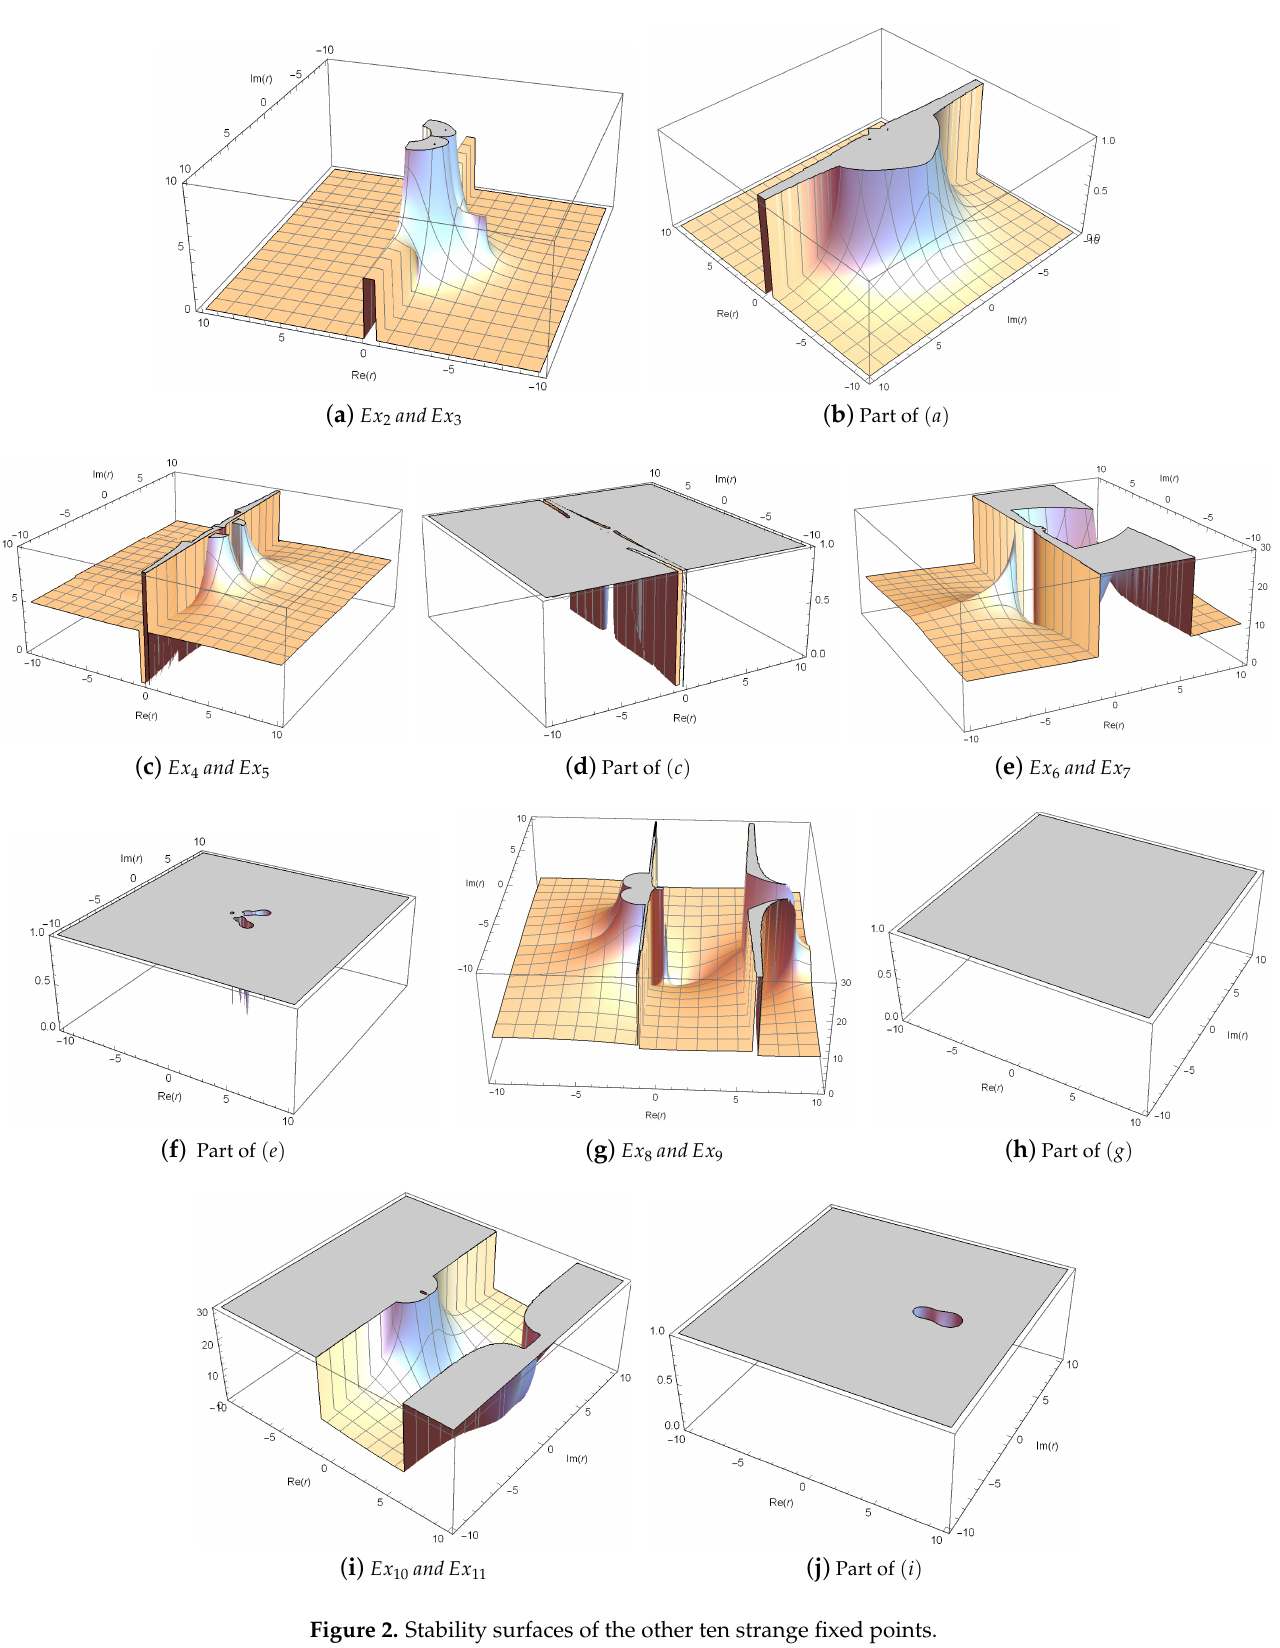
Figure 2. Stability surfaces of the other ten strange fixed